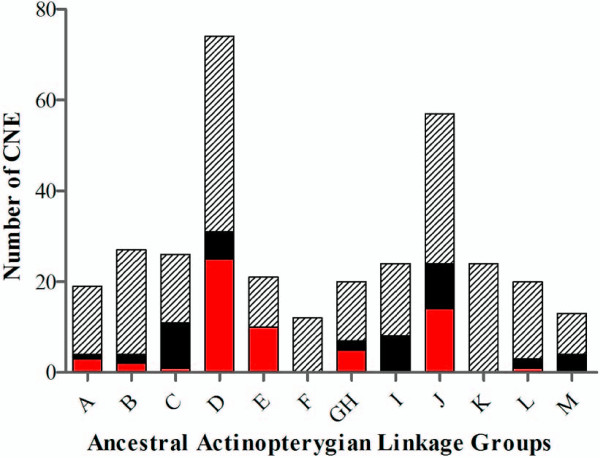
Counts of the number of duplicated conserved noncoding elements (CNE) shared between the zebrafish and medaka genomes that can be traced back to the ancestral Actinopterygian linkage groups. Red = number of duplicates arising solely from an ancestral cluster. Black = number of duplicated CNE with a likely origin from a single ancestral linkage group where the shared paralogy with another cluster could not be excluded. Hatched = number of multiple copy CNE that show paralogy to 2 or more clusters. It should be noted that counts within the hatched stacked bars exceed the actual number of CNE within each category, as a single CNE may share ancestry with 2 or more ancestral linkage groups. Counts within red and black stacked bars correspond to the actual number of duplicated CNE.